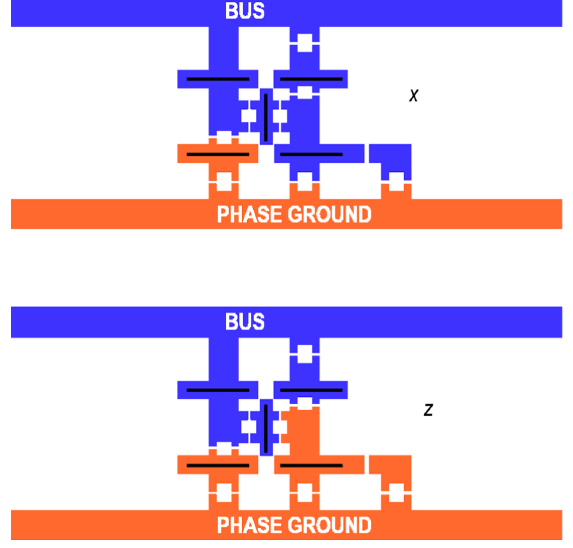
FIG. 12. Measurement of the x and z projections of the lower qubit. The tare measurement (see Fig. 10) allows one to relate the parity of the section coupled to the phase ground to the parity of the section coupled to the bus.